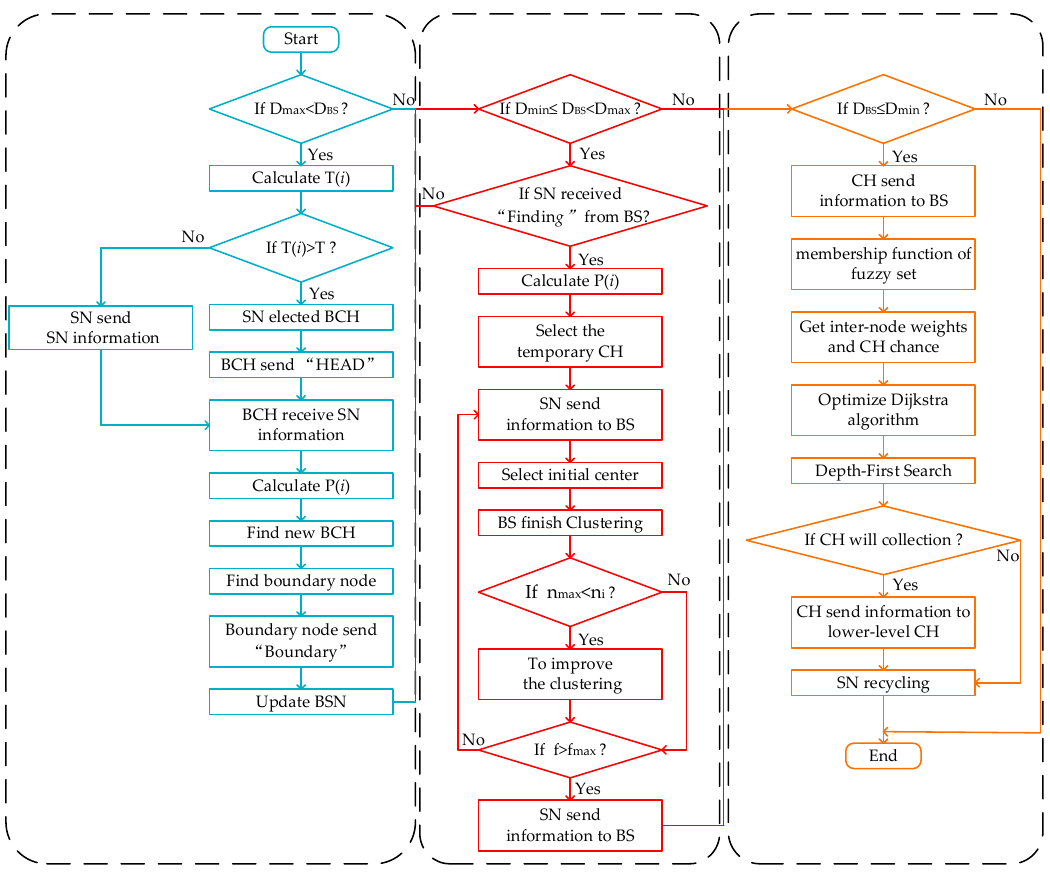
Figure 3. K-means algorithm and fuzzy logic system (KFNS) workflow at each stage.